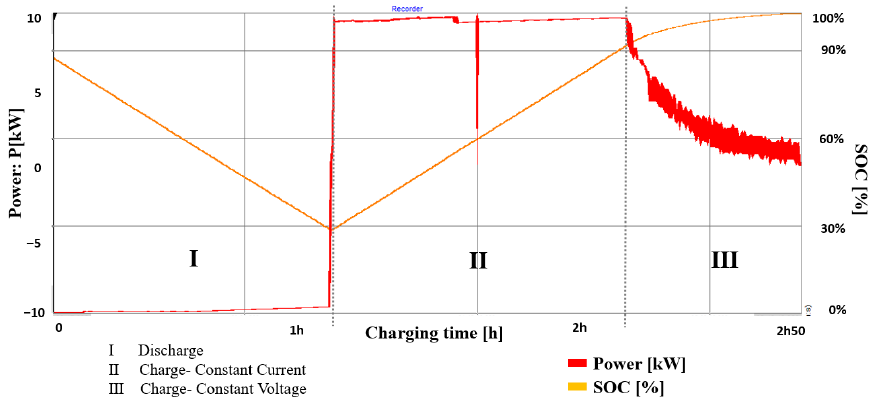
Figure 6. Active Power and SoC during discharge and charge.